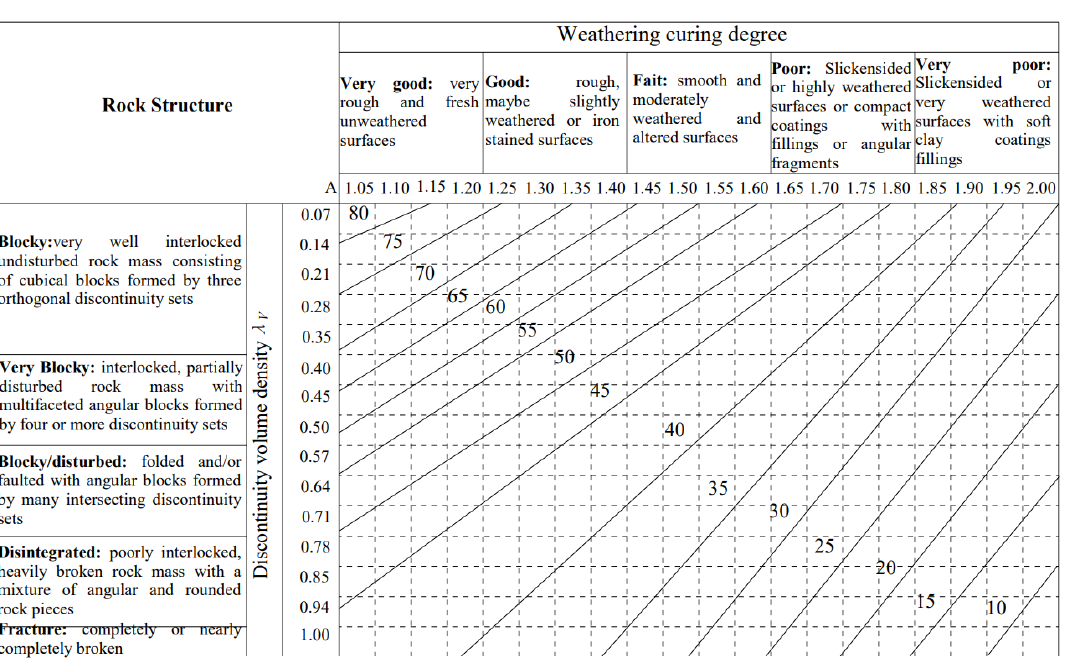
Figure A12. Quantified GSI chart [54].